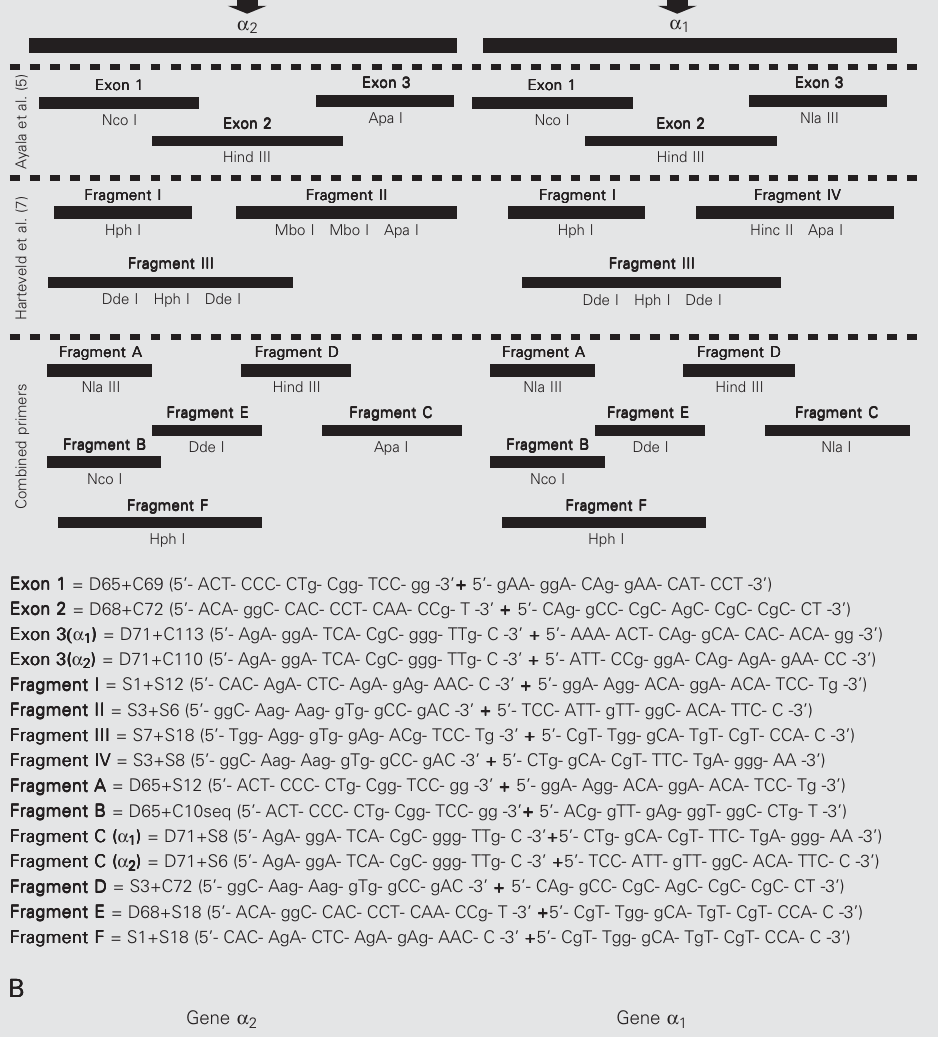
Figure 1. A , Schematic represen- tation of fragment and primer origin. B , Schematic representa- tion of the α -globin gene muta- tions screened by nonradioac- tive single-strand conformation polymorphism in the present study.